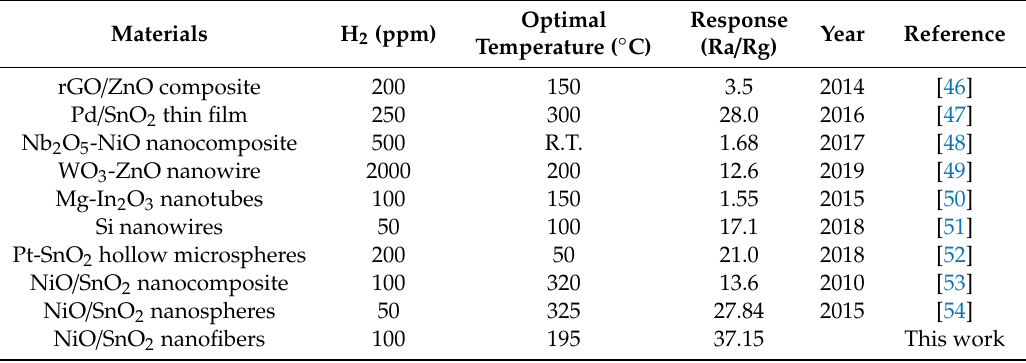
Table 1. Comparison of the H 2 sensing properties with different sensors.